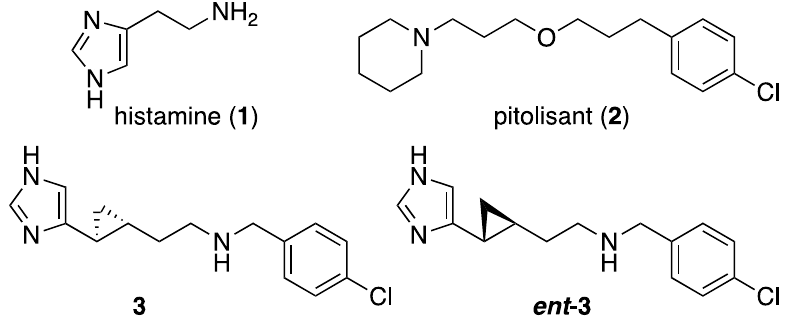
Figure 1. Chemical structures of histamine ( 1 ), pitolisant ( 2 ), and cyclopropane-based conformationally restricted histamine analogues as H 3 /H 4 antagonists ( 3 and ent -3 ).